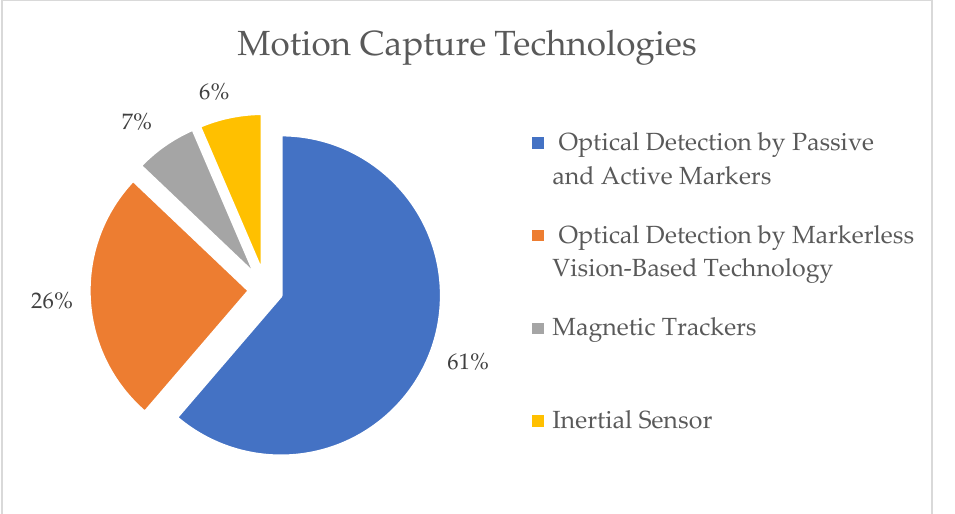
capture system, which uses passive and active markers due to its real-time tracking accu- racy [18]. Approximately 61% of the total literature reviewed in this paper on biomimetics used optical tracking with passive and active markers to measure human subject motion.